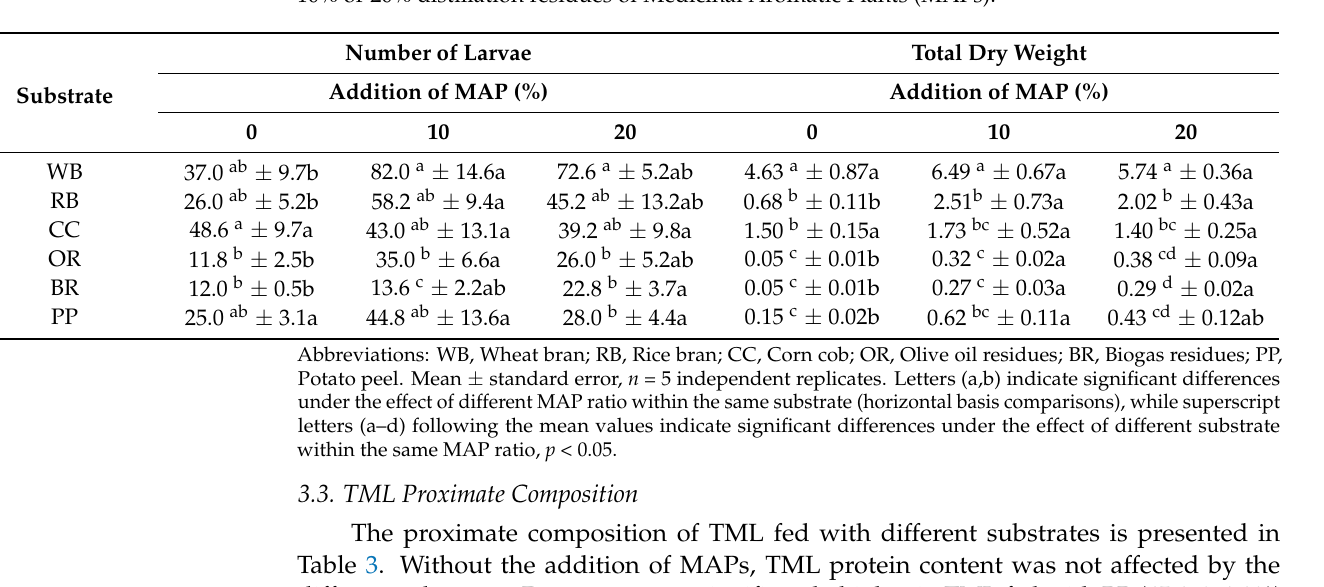
Table 2. Growth of Tenebrio molitor larvae fed agri-food industry by-products, supplemented with 0, 10% or 20% distillation residues of Medicinal Aromatic Plants (MAPs).